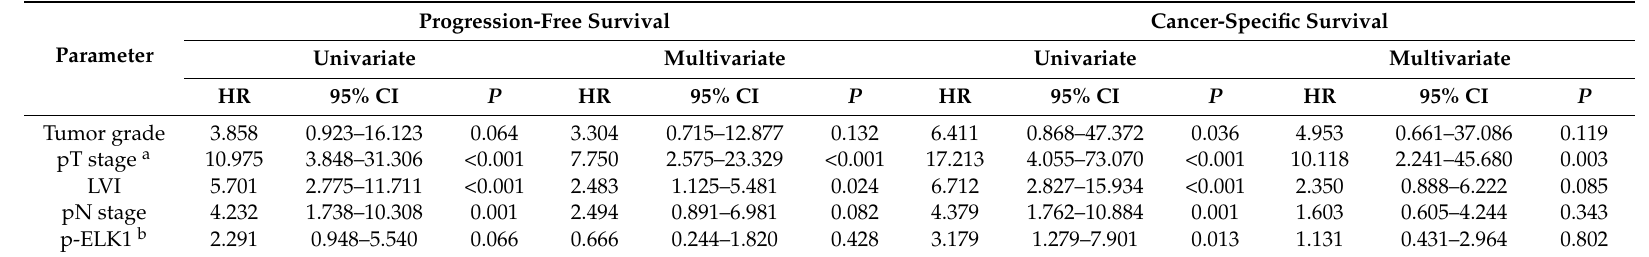
Figure 2. Kaplan-Meier curves for PFS ( a , b ) or CSS ( c , d ) in 95 patients without metastatic disease, according to the status of p-ELK1 expression. Table 4. Univariate and multivariate analysis of PFS and CSS in 95 patients with UUTUC.